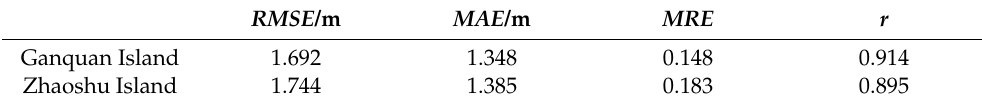
Figure 7. Bathymetric inversion of ( a ) Zhaoshu Island and ( b , c )local details. Table 4. Precision evaluation for the overall water depth estimation. RMSE /m MAE /m MRE